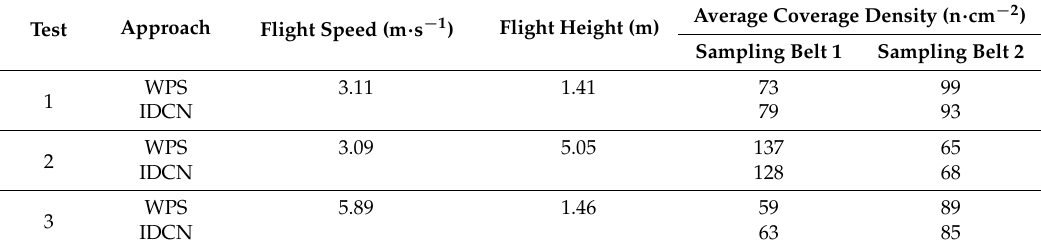
Table 3. Real-time operation parameters of UVAs on each